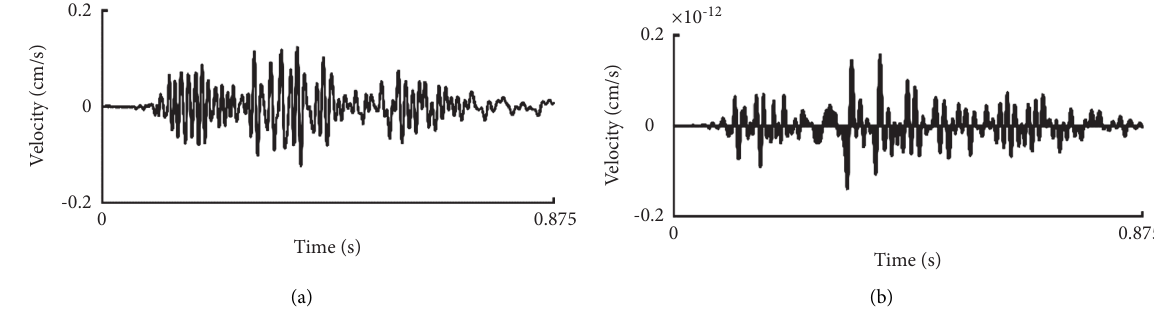
Figure 9: Wavelet reconstruction and error based on db8. (a) Original blasting vibration signals and (b) error of reconstructed